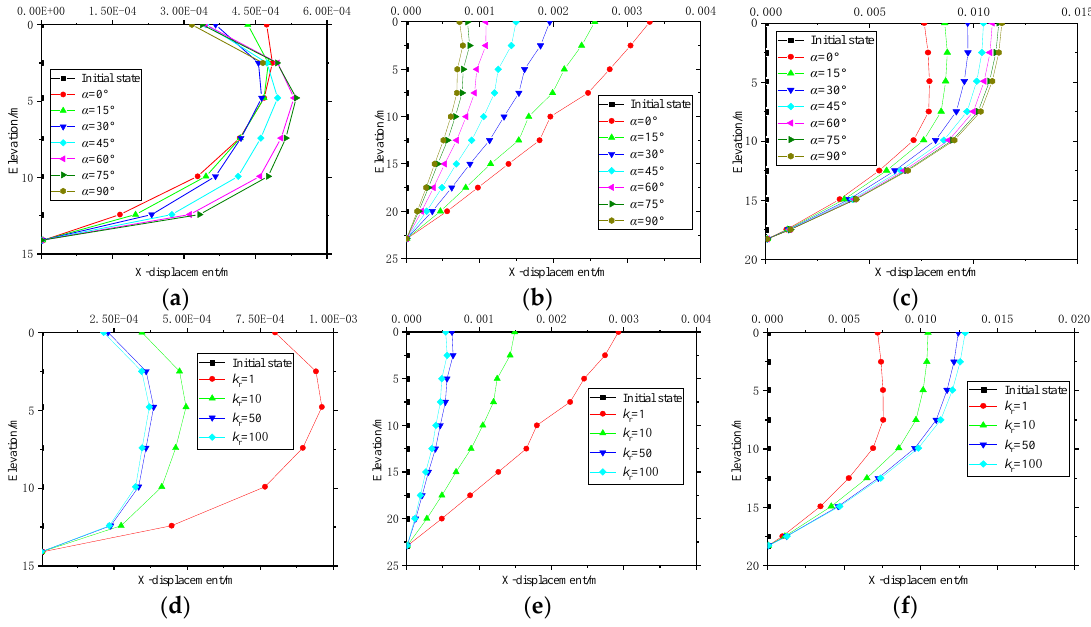
Figure 8. Variations of x -displacement under di ff erent k r and α values for sandy soil. ( a ) Top of the slope with k r = 10. ( b ) Middle of the slope with k r = 10. ( c ) Toe of the slope with k r = 10. ( d ) Top of the slope with α = 45 ◦ . ( e ) Middle of the slope with α = 45 ◦ . ( f ) Toe of the slope with α = 45 ◦